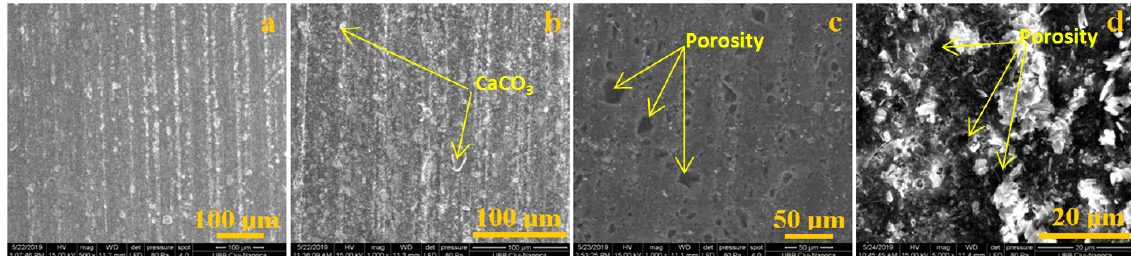
Figure 4. SEM images for exterior area: ( a ) control group; ( b ) exposed to rainwater; ( c ) exposed to acetic acid; ( d ) exposed to sulfuric and nitric acid.